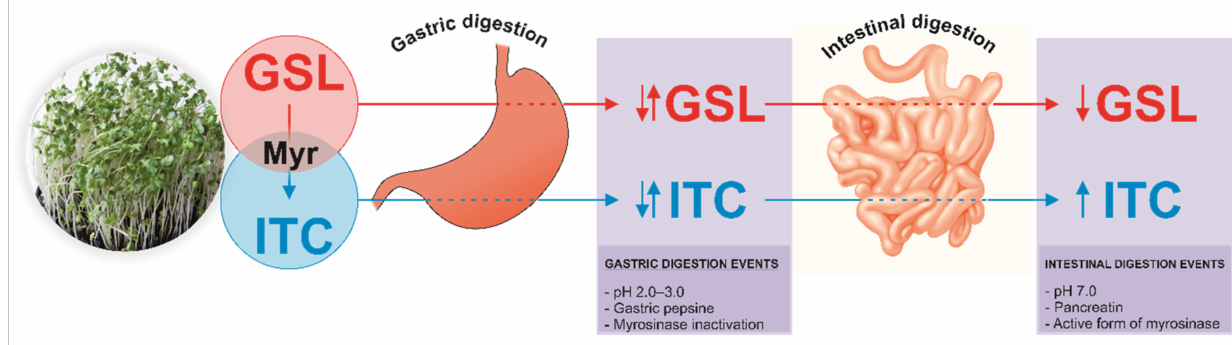
Figure 1. Schematic representation of the factors involved in the stability of glucosinolates (GSLs) and isothiocyanates (ITCs) during gastrointestinal digestion. Myr,